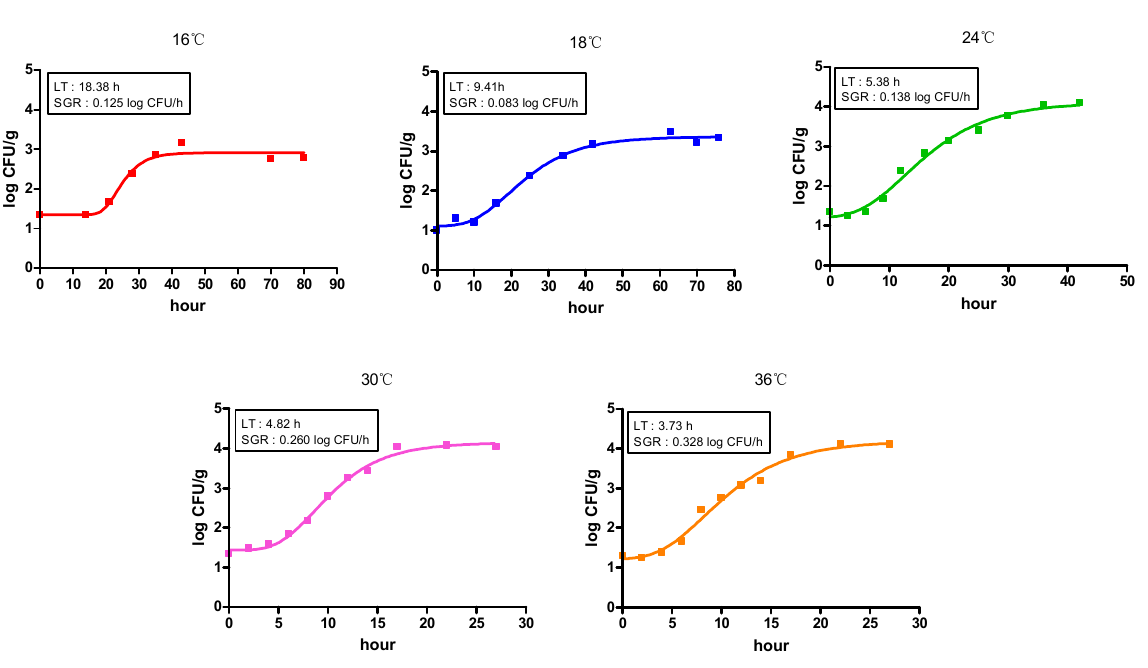
Figure 2. Growth curves of natural V. vulnificus in oyster as a function of time at various temperatures. Data (n = 4) were fitted using Equation (1). LT: lag time, SGR: specific growth rate